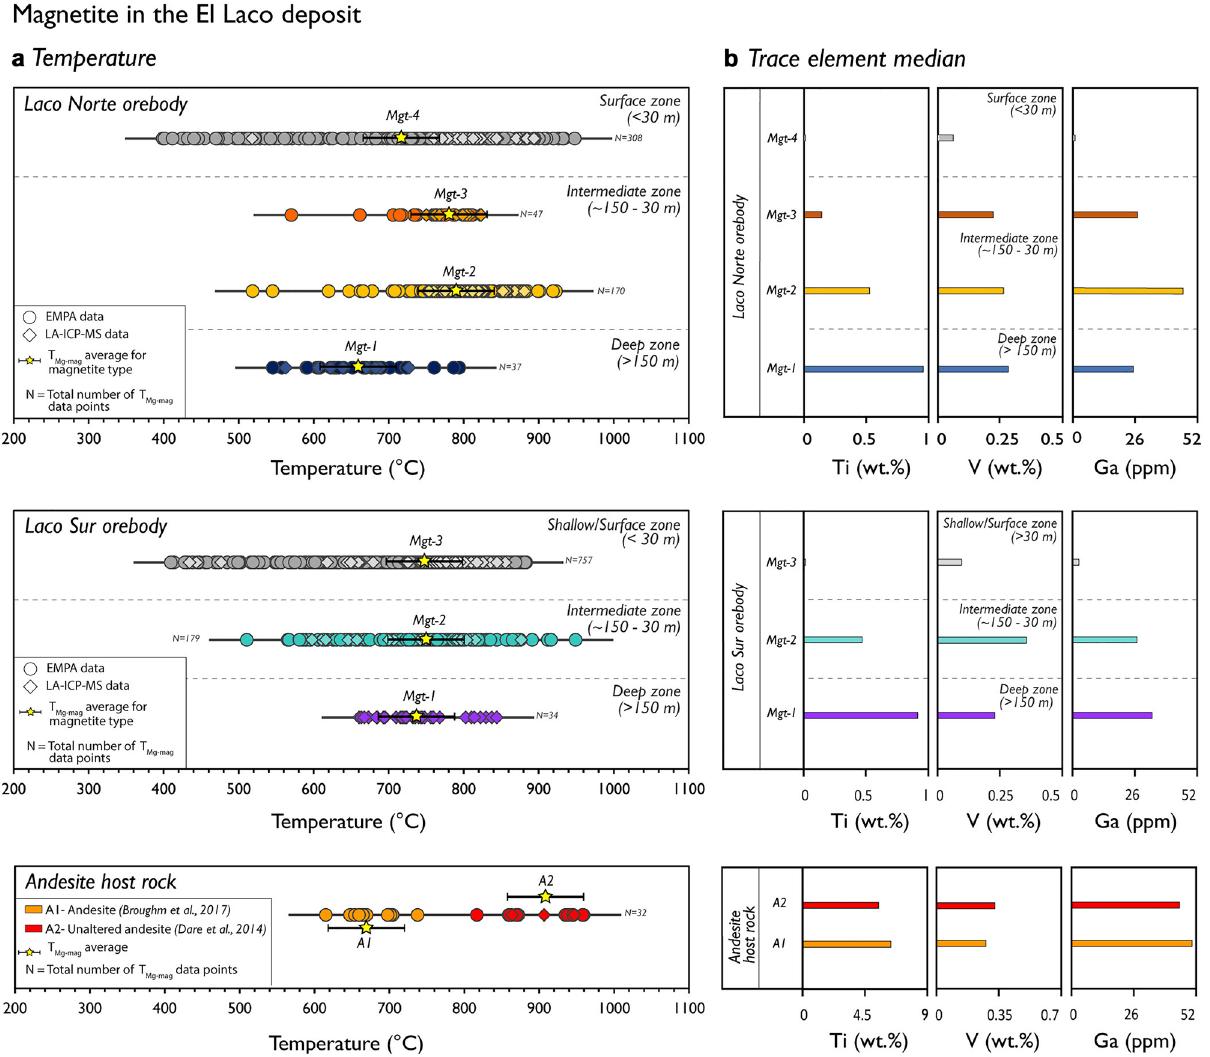
Figure 3. Calculated temperatures and median concentrations of selected trace elements in magnetite from El Laco orebodies and its andesitic host rocks. (a) Temperatures calculated using the T Mg-mag 43 thermometer. Uncertainties (error bars) in T Mg-mag are at ± 50 °C. (b) Titanium, V and Ga median concentrations determined by